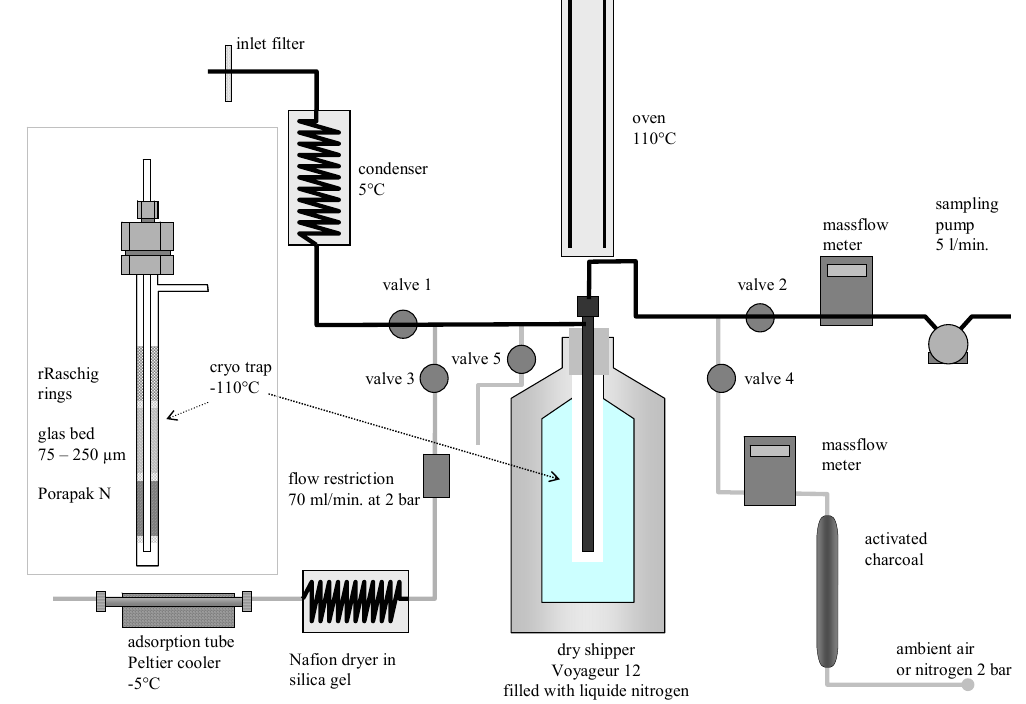
Fig. 1. Scheme of the sampling Figure 1. Scheme of the sampling system